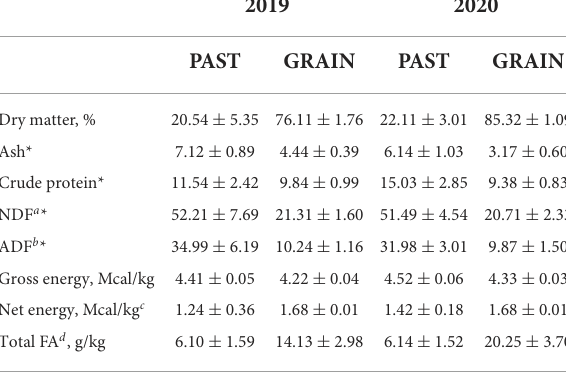
TABLE 1 Nutritive value of the